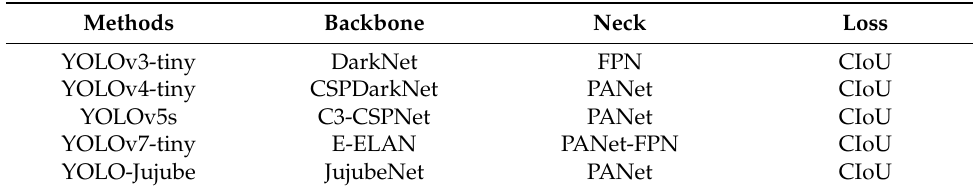
Table 3. List of trained models.